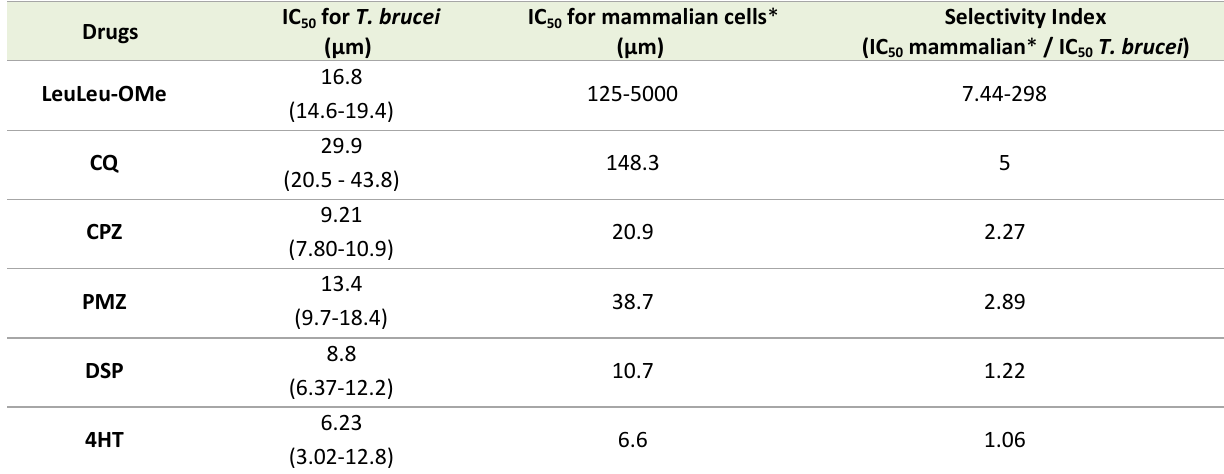
IC for mammalian cells 50